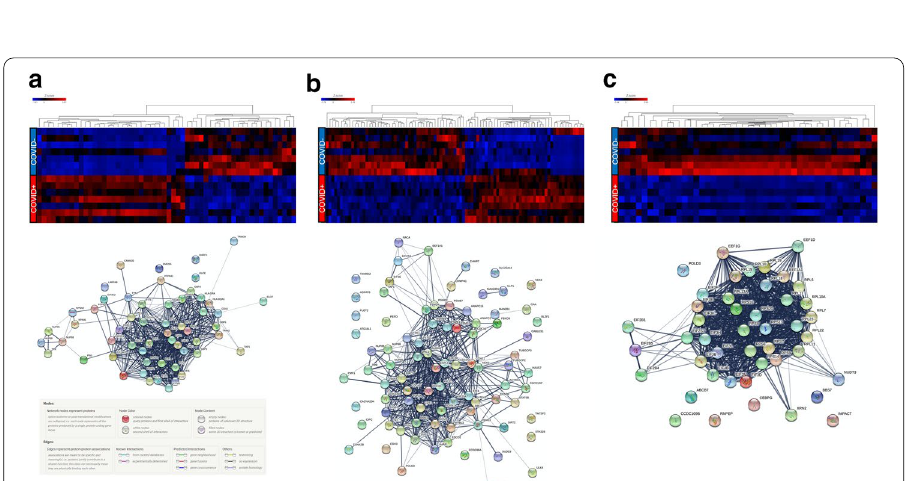
Fig. 3 Gene expression and predicted protein–protein interaction networks of transcriptional differences in circulating leukocytes from COVID19 and COVID19 critically ill patients. Differentially expressed genes + − (1311) were submitted to the Reactome Pathway Browser, resulting in the identification of three major pathway classifications (shown as heat maps, left to right): a interferon (interferon signalling, interferon alpha/ beta signalling, anti-viral mechanism by IFN-stimulated genes); b cell cycle regulation (cell cycle, mitotic, G1/S transition, mitotic G1 phase and G1/S transition, G1/S-specific transcription); and c protein translation/ ribosomes (GTP hydrolysis and joining of the 60S ribosomal subunit, formation of a pool of free 40S subunits, formation of the ternary complex, the 43S complex, eukaryotic translation initiation, Cap-dependent translation initiation, L13a-mediated translational silencing of ceruloplasmin expression, eukaryotic translation elongation, peptide chain elongation, translation initiation complex formation, response of EIF2AK4 (GCN2) to amino acid deficiency). The gene lists corresponding to these three pathway classifications were submitted to String-db (https ://strin g-db.org/cgi/input .pl) to predict the protein–protein interaction networks (shown below each corresponding heat